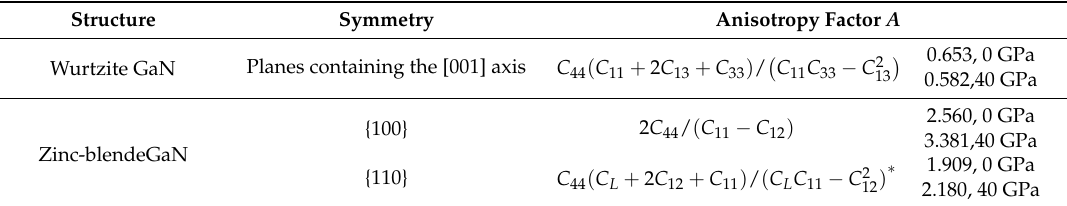
Table 4. Anisotropy factors for two GaN single